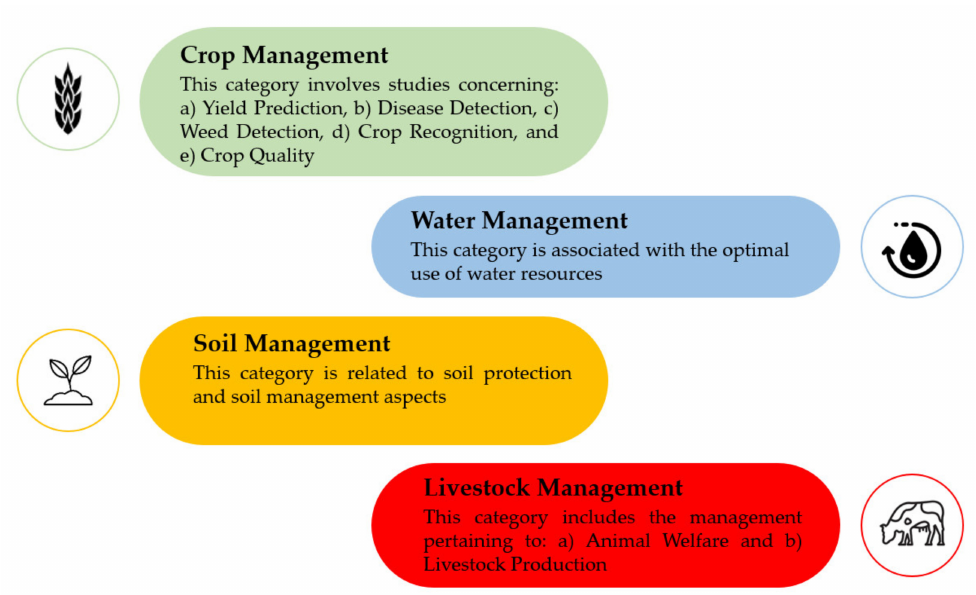
Figure 1. The four generic categories in agriculture exploiting machine learning techniques, as presented in